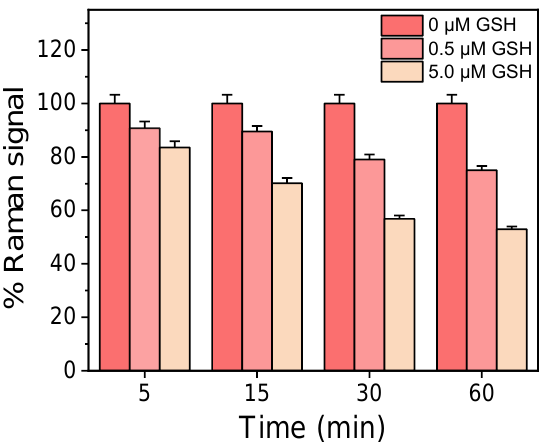
Figure 4. Percent signal obtained from SiNWs/Ag nanoparticles substrates incubated with aqueous GSH solutions with a concentration of 0.5 and 5 µ M for 5, 15, 30, and 60 min with respect to the signal obtained in the absence of GSH. All substrates have been modified prior to the incubation with the GSH solutions with a 3 µ g/mL CV solution for 30 min. Each point is the mean value of measurements received from 3 substrates (3 different spots per substrate) ± SD.